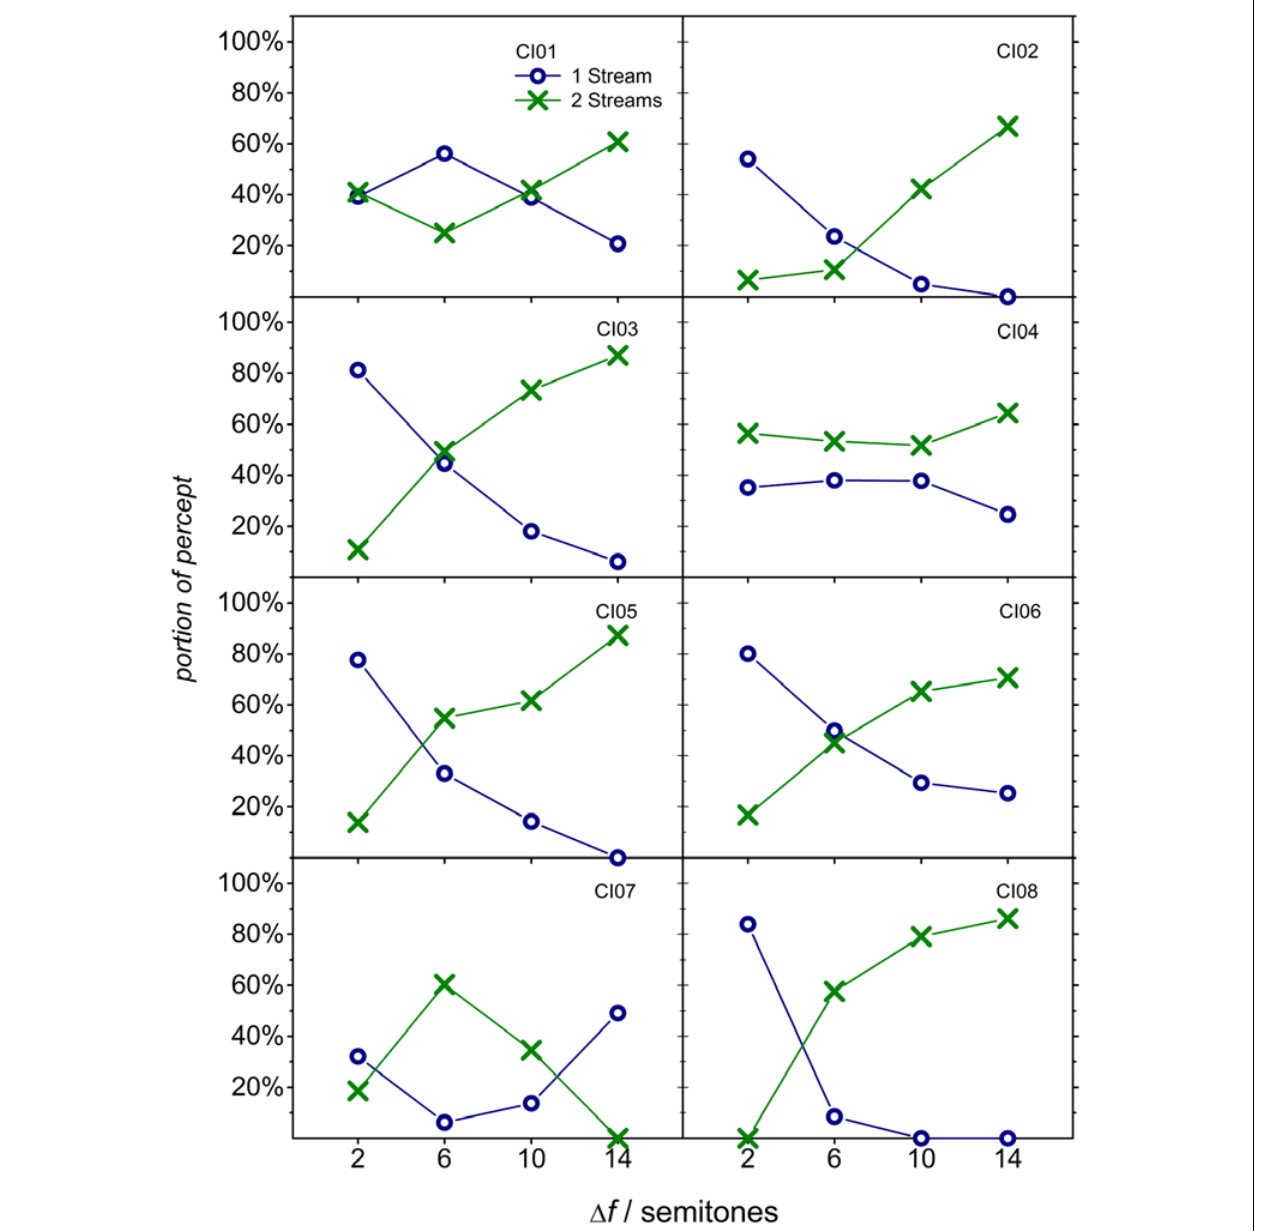
FIGURE 1 | Individual durations of answering options “two-streams” (green cross marks) and “one-stream” (blue circles), calculated as proportions of the total sequence duration (30 s), are plotted as a function of the (average) (cid:2) f for each listener.